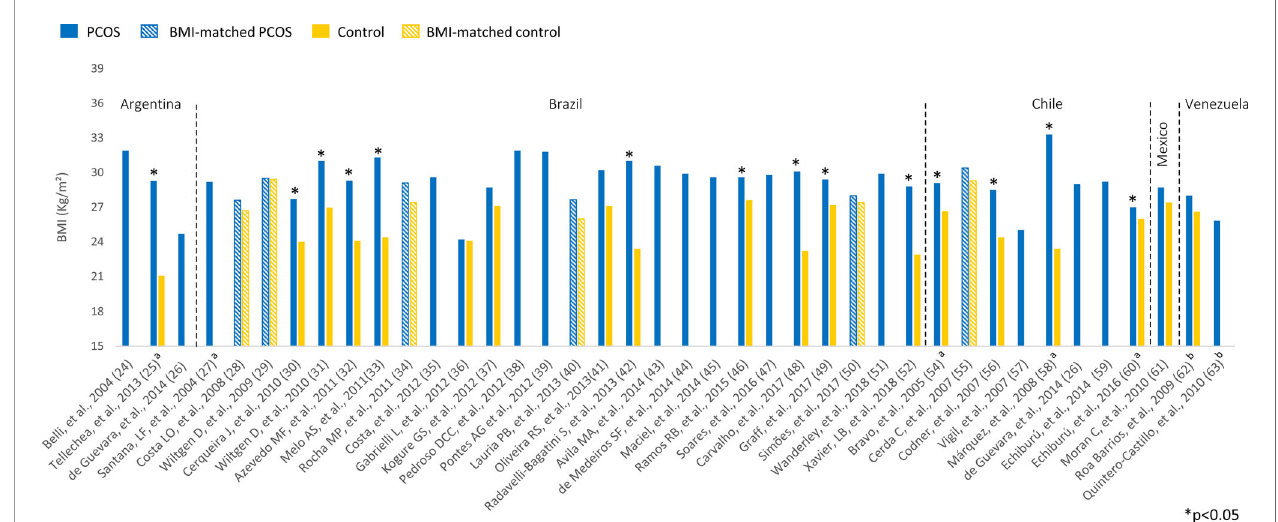
FIGURE 2 | BMI (kg/m²) among Latin American women with PCOS and controls. Mean values. The “ x ” axis shows the name of studies and reference numbers (refer to the text). a PCOS diagnosis according to NIH criteria; b PCOS diagnosis de fi ned by the